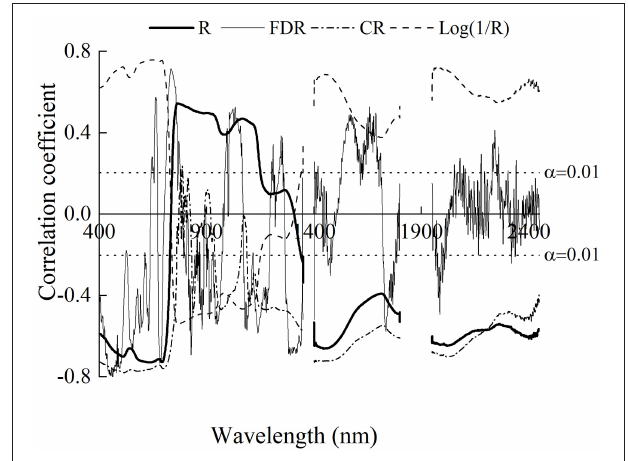
FIGURE 4 | The relationships between leaf nitrogen accumulation and the original reflectance and spectrum with different transformation methods. The dash lines represent the critical value of correlation coefficient at α =